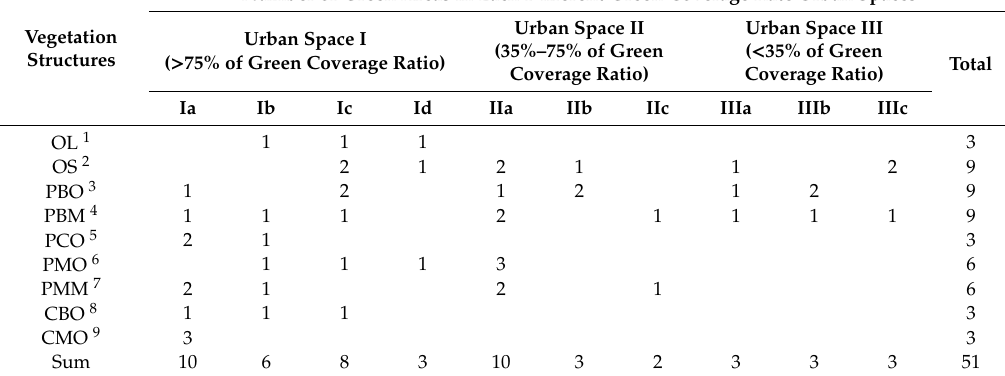
Figure 2. Distribution of nine different vegetation structure plots and their repetition in urban space with three different green coverage rates. Table 2. Type, repetition, and distribution of vegetation structure in urban space with three different green coverage rates.